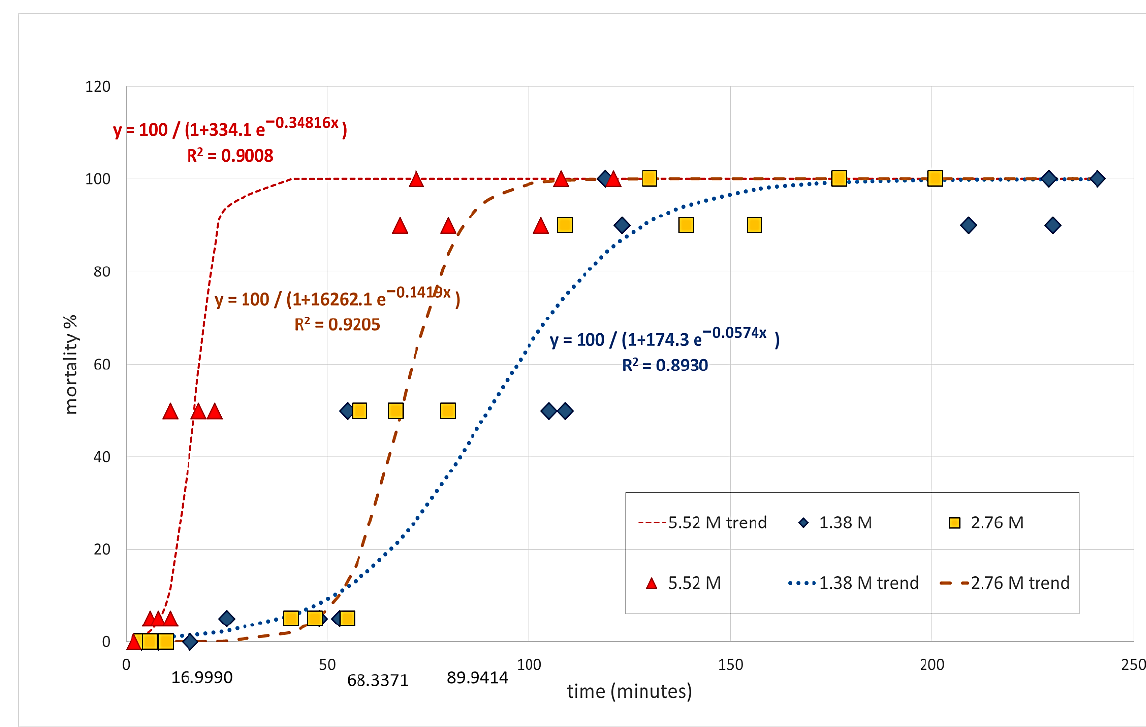
Figure 1. Abbott-corrected mortality rates for the three treatments. Table 1. Mean ± SE (standard error) of time (in minutes) elapsed after treatment till the occurrence of